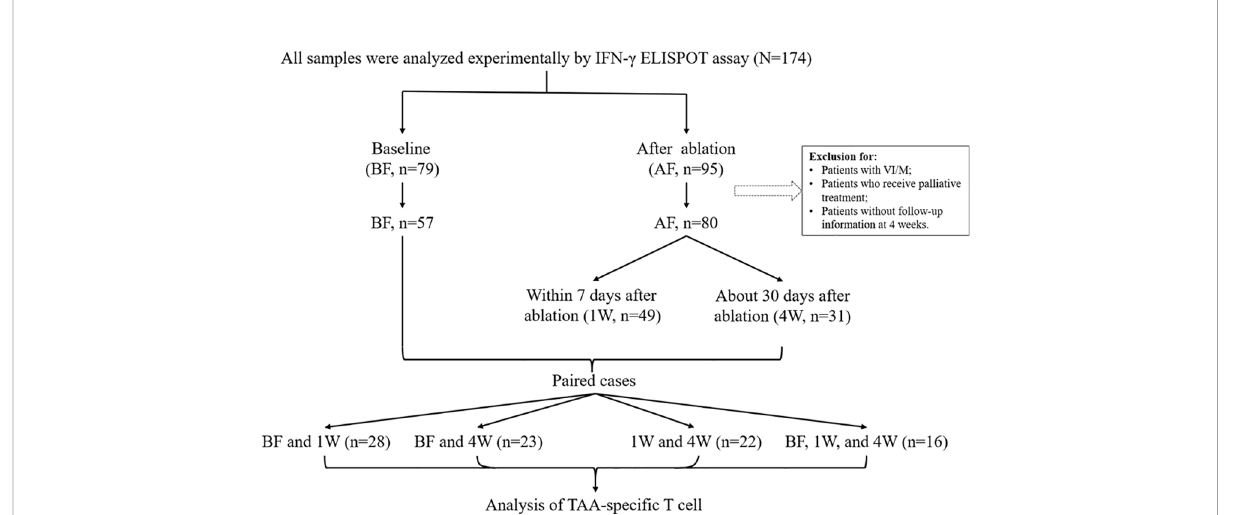
FIGURE 1 Patient cohort and study design. 174 HCC PBMCs were initially included in this study. Among them, 79 samples were before treatment (BF), and 95 samples were that had received ablation treatment (AF). In consideration of the disease condition and the effect of treatment, samples from patients with vascular invasion/metastasis and without curative therapy were excluded. Thus, there were 57 samples at BF and 80 samples at AF. In the AF group, there were 49 samples were enrolled at 1-week (1W) and 39 samples at 4-week (4W). Paired cases were analyzed in 28 samples at BF and 1W, in 23 samples at BF and 4W, in 22 samples at 1W and 4W, two timepoints, and 16 samples at BF, 1W and 4W, three timepoints. Clinical data were collected from the